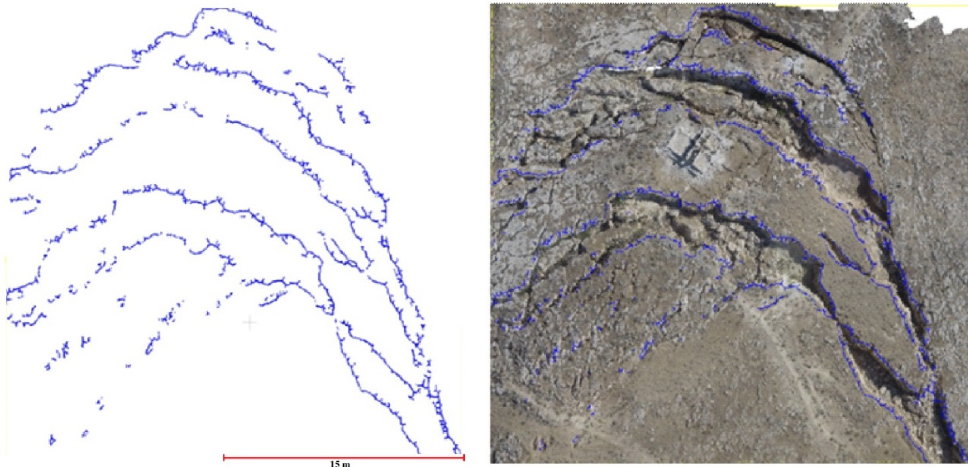
Figure 21. Final landslide scarp detection results (blue) overlaid on the orthophoto generated used UAV images of the study area.